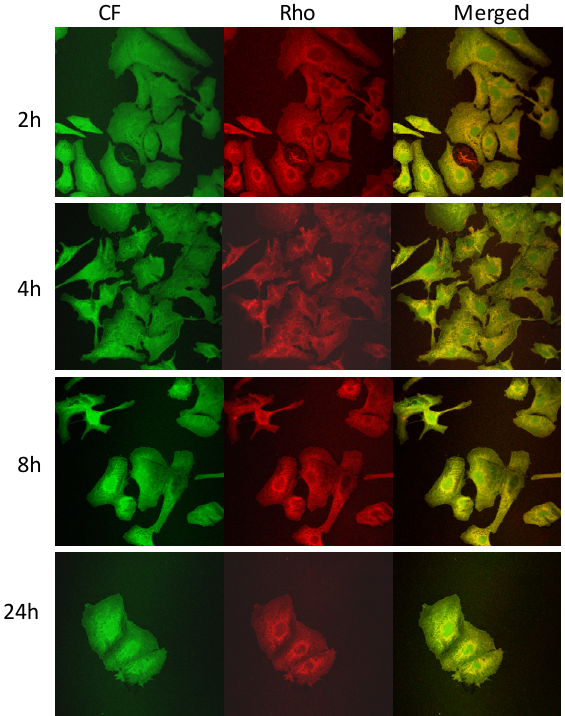
Figure 6. Images of A549 cells incubated for 2, 4, 8 and 24 h with Rho-PE labeled and CF loaded PC60 Chol OA liposomes. The localization and intensity of dyes are displayed in red for Rho-PE, in green for